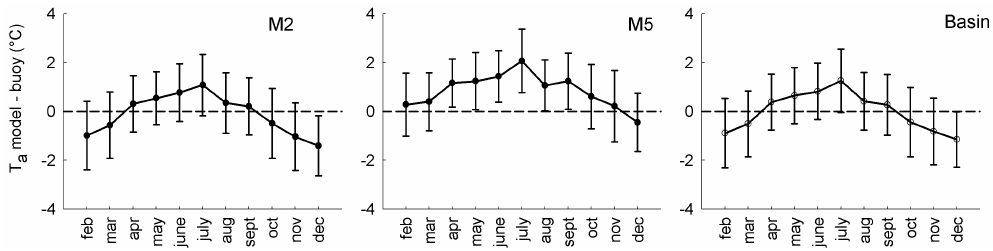
Fig. 8. Differences of monthly mean air temperature ( T a ) values between the model and the buoy in the M2, M5 grid points and for the “average basin” data.